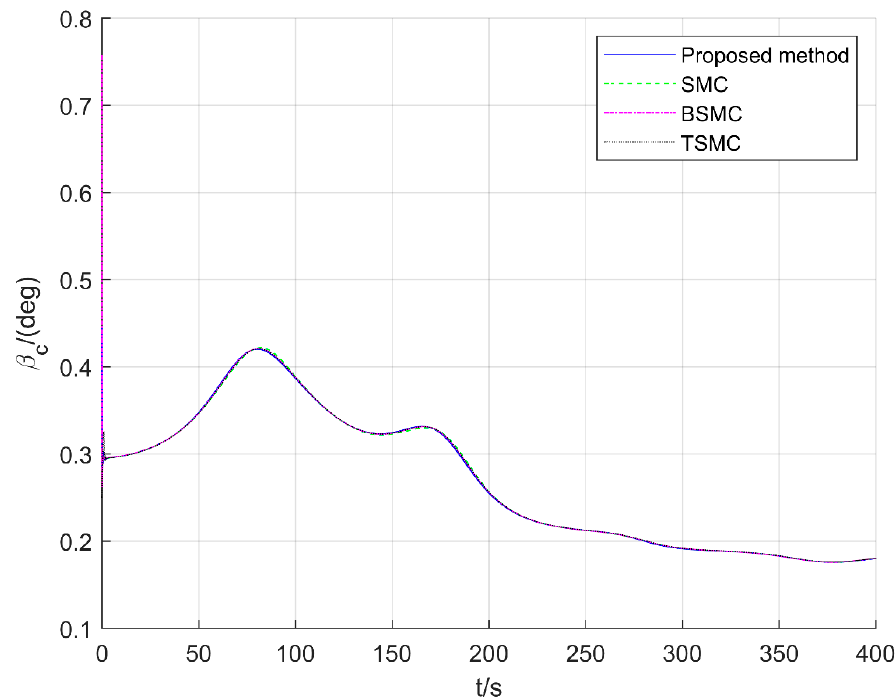
Figure 12. Responses of mass.